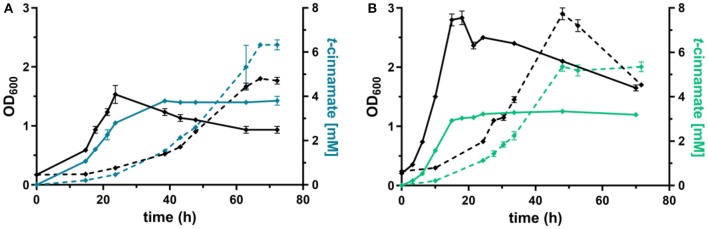
Shake flask cultivations of P. taiwanensis GRC3 Δ8ΔpykA-tap with varying heterologous expression modules. (A) Growth (black lines) and t-cinnamate production (blue lines) by P. taiwanensis GRC3 Δ8ΔpykA-tap attTn7::P14gAtPAL- aroGfbr-pheAT310 in MSM containing 20 mM glucose (solid line) or 40 mM of glycerol (dotted line). (B) Growth (black lines) and t-cinnamate production (green lines) by P. taiwanensis GRC3 Δ8ΔpykA-tap attTn7::P14fAtPAL in MSM containing 20 mM glucose (solid line) or 40 mM of glycerol (dotted line). Error bars represent the standard error of the mean (n = 3).